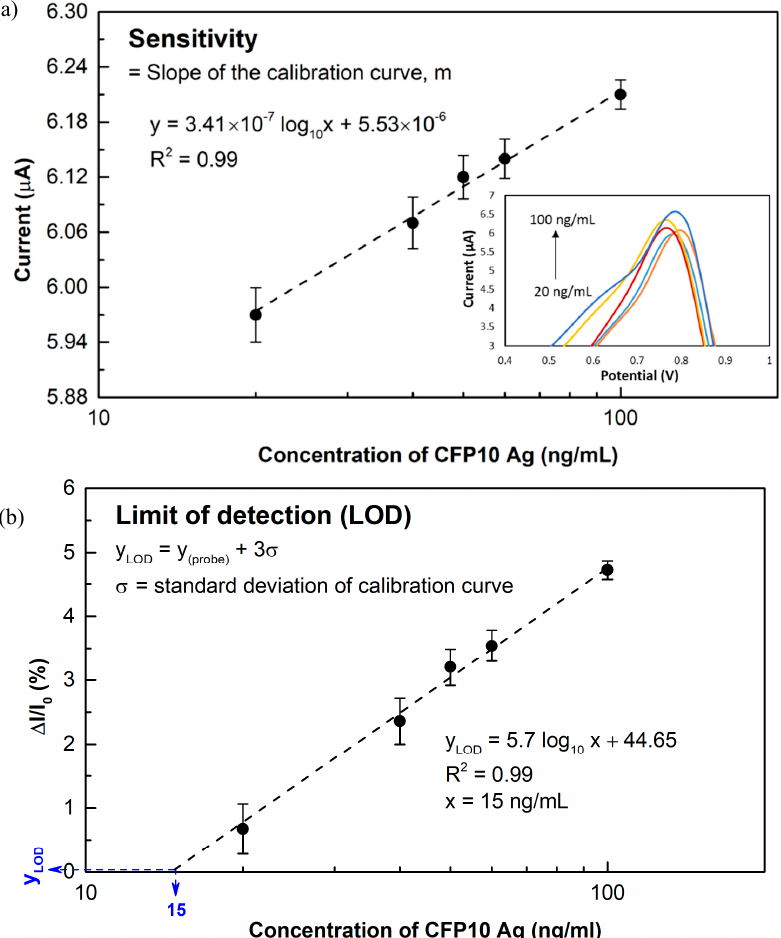
Figure 6. ( a ) Sensitivity study for the detection of CFP10 at concentrations in the range of 20–100 ng/mL. Inset image shows the DPV responses of the sensor towards the different concentrations of CFP10. ( b ) Calibration curve of the relative change in current with estimated LOD. Table 1. Linearity range and LOD of CFP10 antigen using different immunoassay method. No.